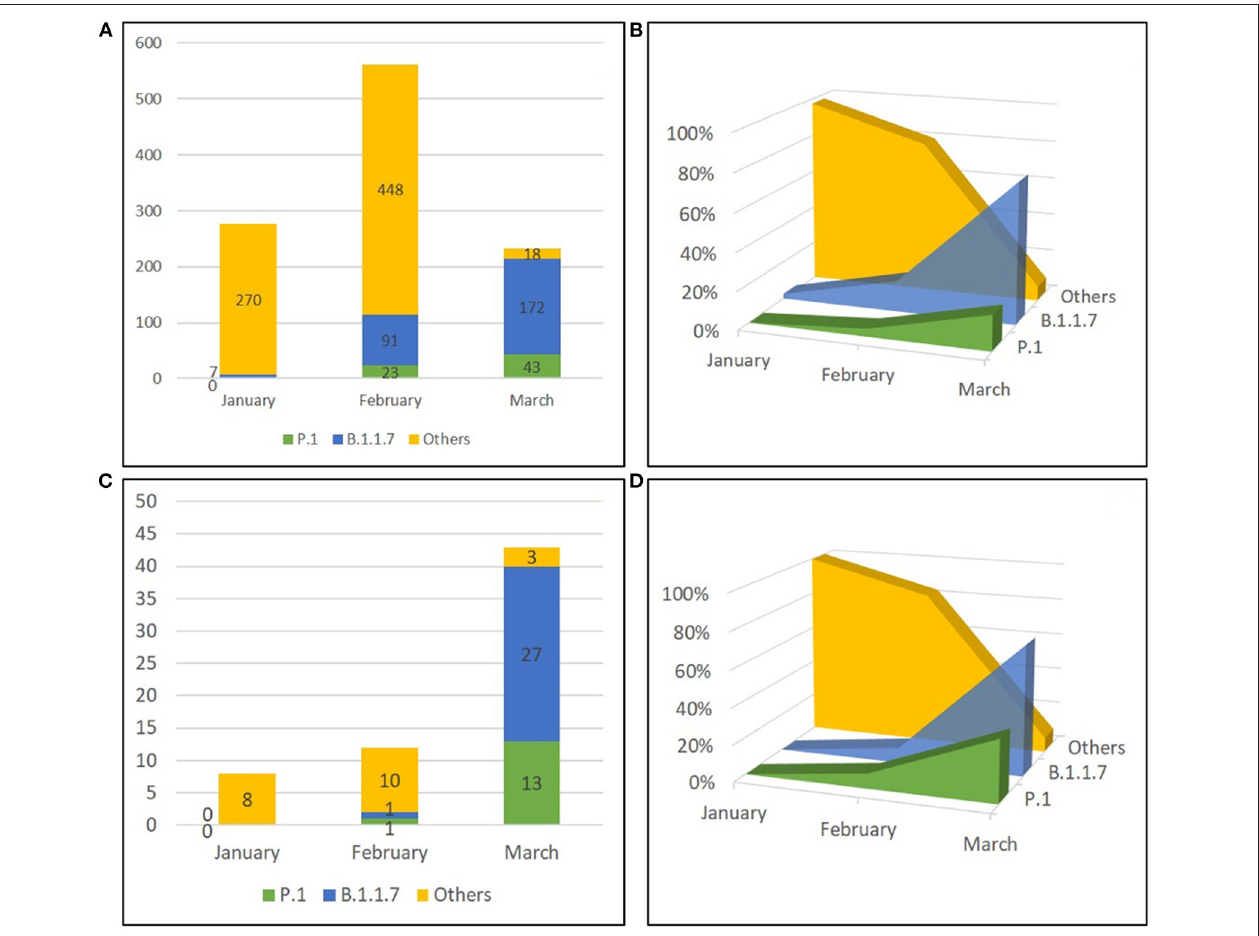
FIGURE 2 | Temporal distribution of PANGO lineages of SARS-CoV-2 genomes. Sequences obtained from unvaccinated individuals (A,B) and from vaccinated subjects (C,D) in Lazio Region (Central Italy) between January and March 2021 are shown as absolute frequencies (A, C) and percentages (B,D) . Others included strains belonging to B.1.177 lineage, B.1.525 lineage, B.1.1 lineage, B.1.1.39 lineage, B.1 lineage, and B.1.258.17